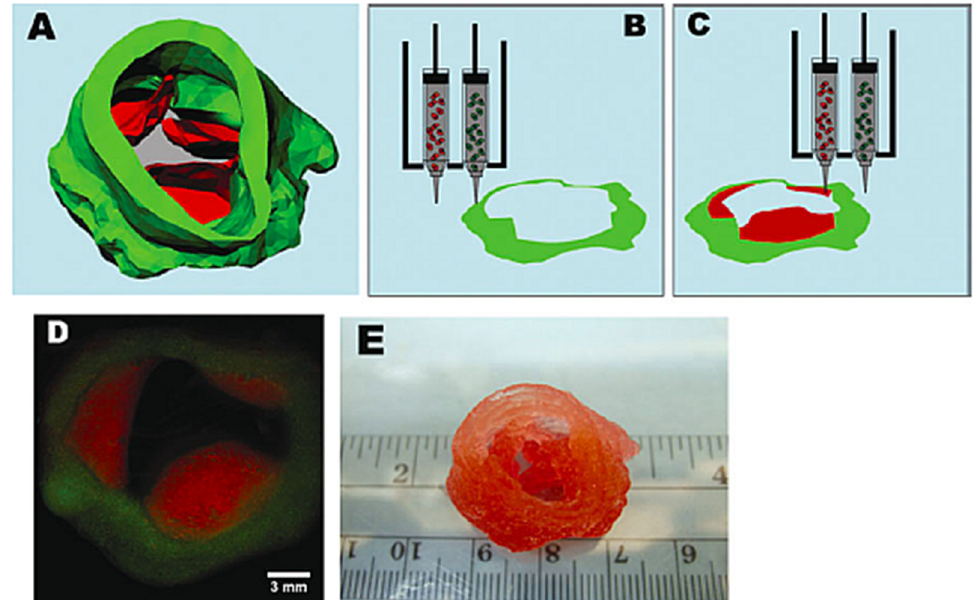
Figure 8. The 3D bioprinting of an aortic valve conduit. ( A ) The 3D reconstruction of an aortic valve model. The green color indicates valve root and the red color indicates valve leaflets. Schematic illustration of the 3D bioprinting process using alginate and gelatin as bioinks encapsulated with ( B ) sinus smooth muscle cells (SMCs) and ( C ) aortic valve leaflet interstitial cells (VIC) cells. ( D ) Fluorescent image of two 3D bioprinted layers representing an aortic valve conduit. ( E ) Macroscopic image of a 3D bioprinted aortic valve conduit. Reprinted from a previous study [196] with permission.